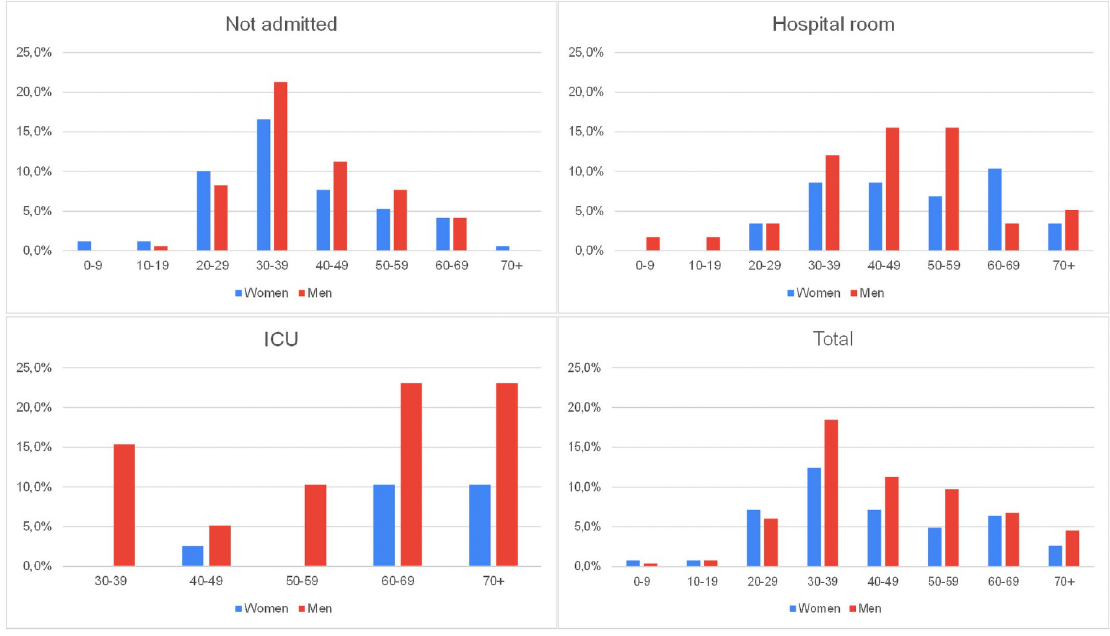
Fig 2. Distribution of patients according to age, sex, and